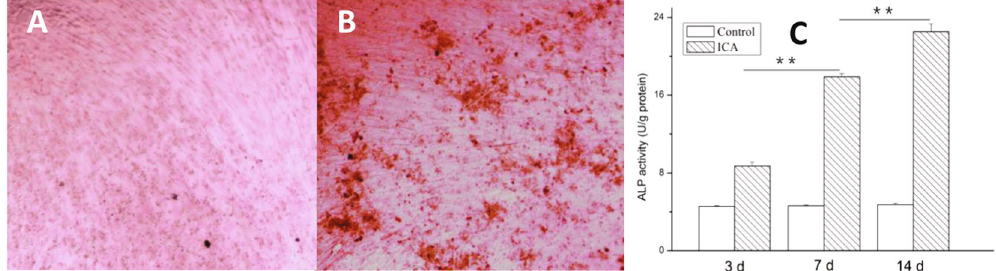
Figure 5. Alizarin Red staining and ALP assay of BMMSCs cultured in ICA-SF/PLCL nanofibrous membrane– released medium. ( A ) Mineralized deposits were not obvious by Alizarin Red staining after 14 d in the control group (x40). ( B ) Mineralized deposits were obvious by Alizarin Red staining after 14 d in the test group (x40). ( C ) ALP activity in the test groups rose at 3, 7, and 14 d. ICA indicates ICA-SF/PLCL drug-loaded nanofibrous membrane group.